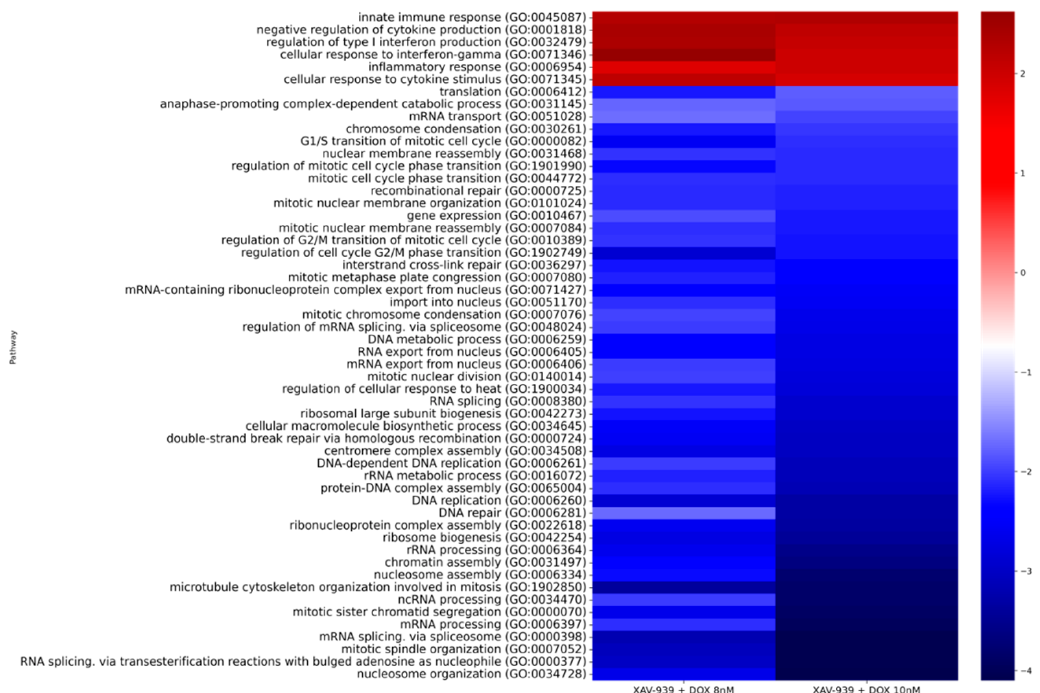
Figure 3. Heat map showing overall results of pathway enrichment analysis according to the Gene Ontology Biological Process 2021 database for PC3 cells treated with XAV939+DOX 8 nM and XAV939+DOX 10 nM compared to control PC3 cells.